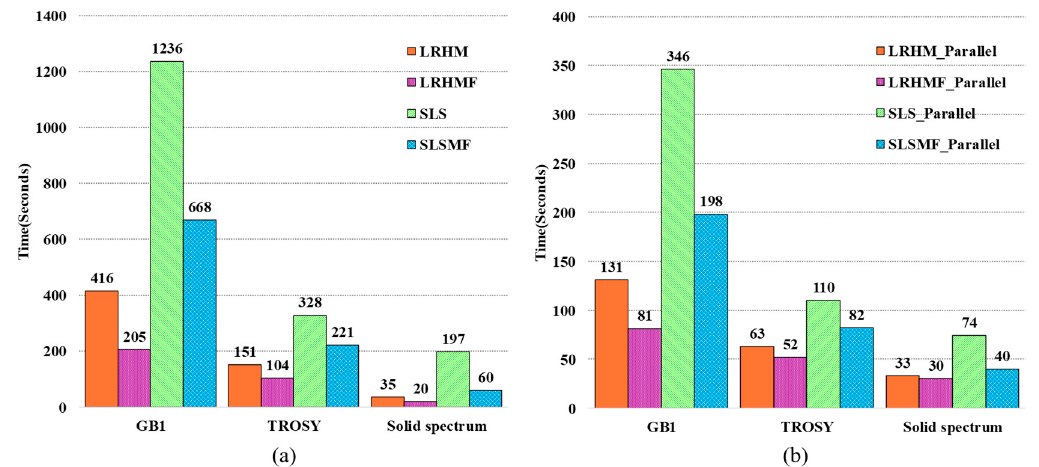
Figure 12. The computation time of spectra reconstruction on a personal computer. ( a , b ) computation time of spectra reconstruction without and with parallel computing, respectively. Note: All reconstruction algorithms were performed using MATLAB 2017b (Mathworks Inc., Natick, MA, USA) on a personal computer with 1.80 GHz 4 cores CPU and 8 GB RAM. The switching on and off parallel pool takes an average of 24 s.